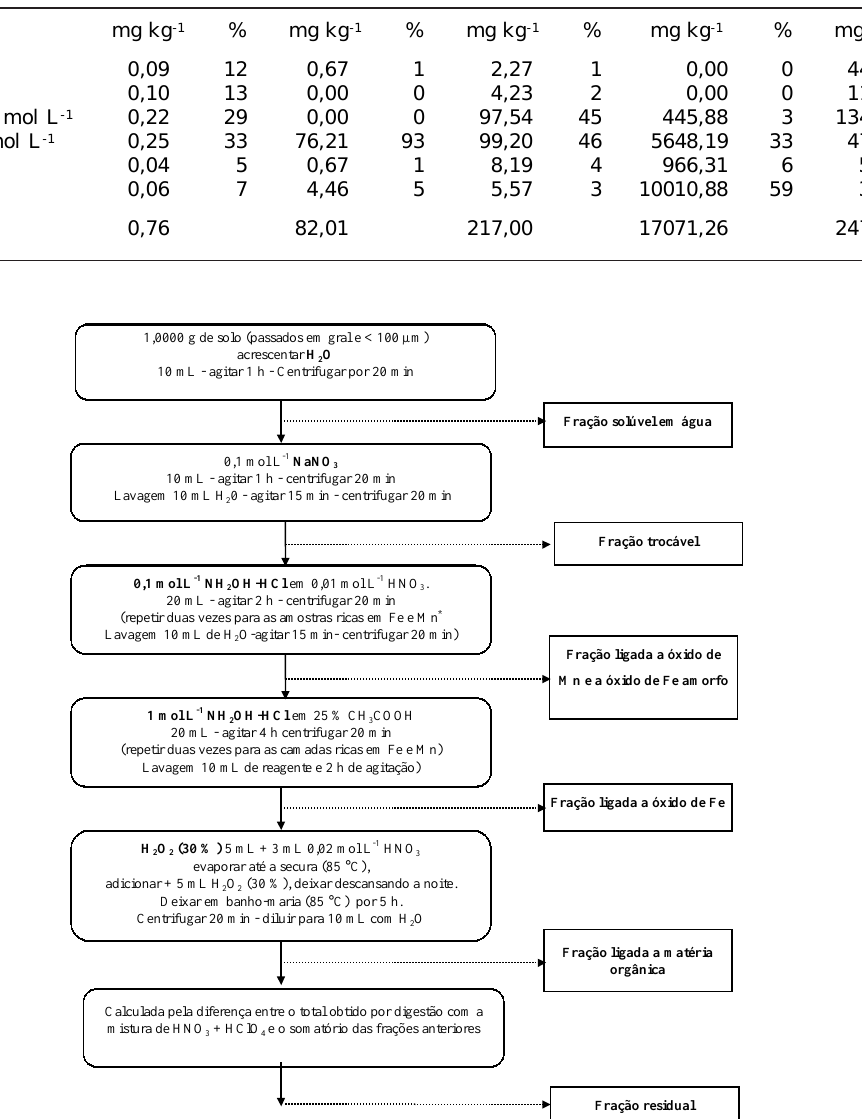
Figura 1. Esquema de extração seqüencial de Keller & Védy